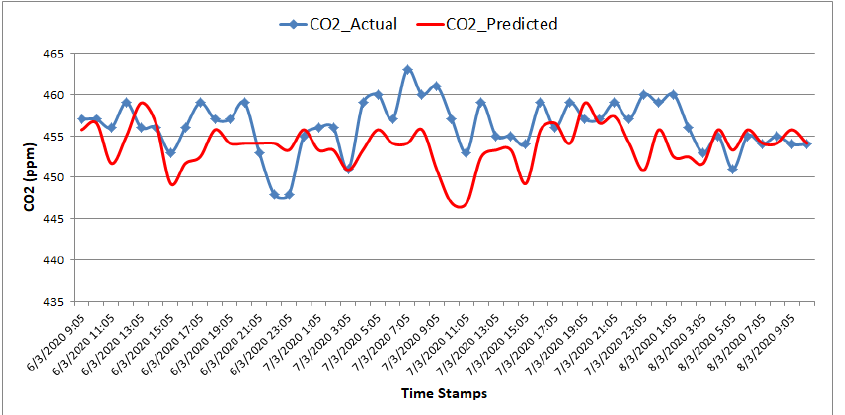
Figure 14. Predicted values of CO 2 after every 5 min vs Actual values.